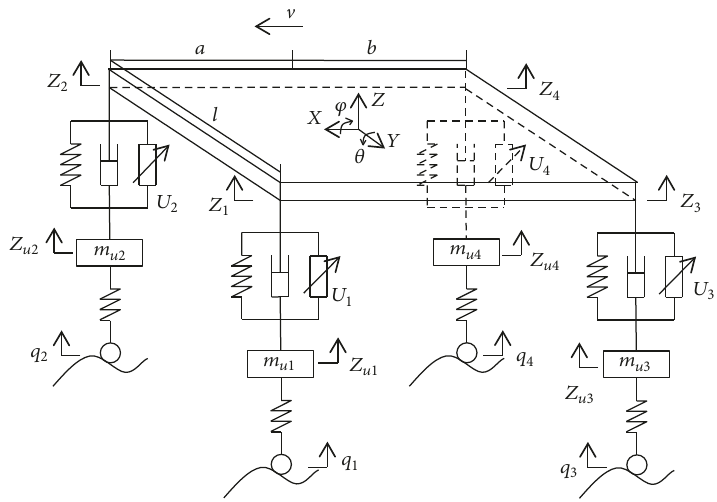
Figure 1: 7-DOF model of active suspension